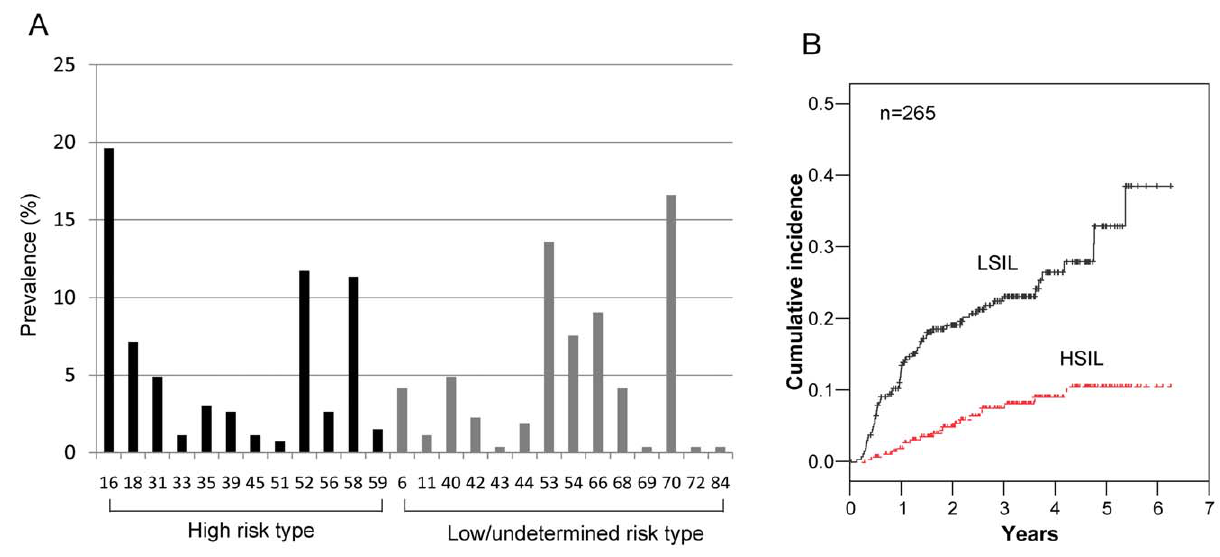
Figure 1. The prevalence rates of HPV genotypes and cervical abnormalities in women with HPV-positive and cytology-negative results. The prevalence rates of different HPV genotypes in 265 women with HPV-positive and cytology-negative results (A). Cumulative incidence rates of low-grade squamous intraepithelial lesions (LSIL) and high-grade squamous intraepithelial lesions (HSIL) based on 265 women with HPV- positive including high-risk and low-risk types (B).